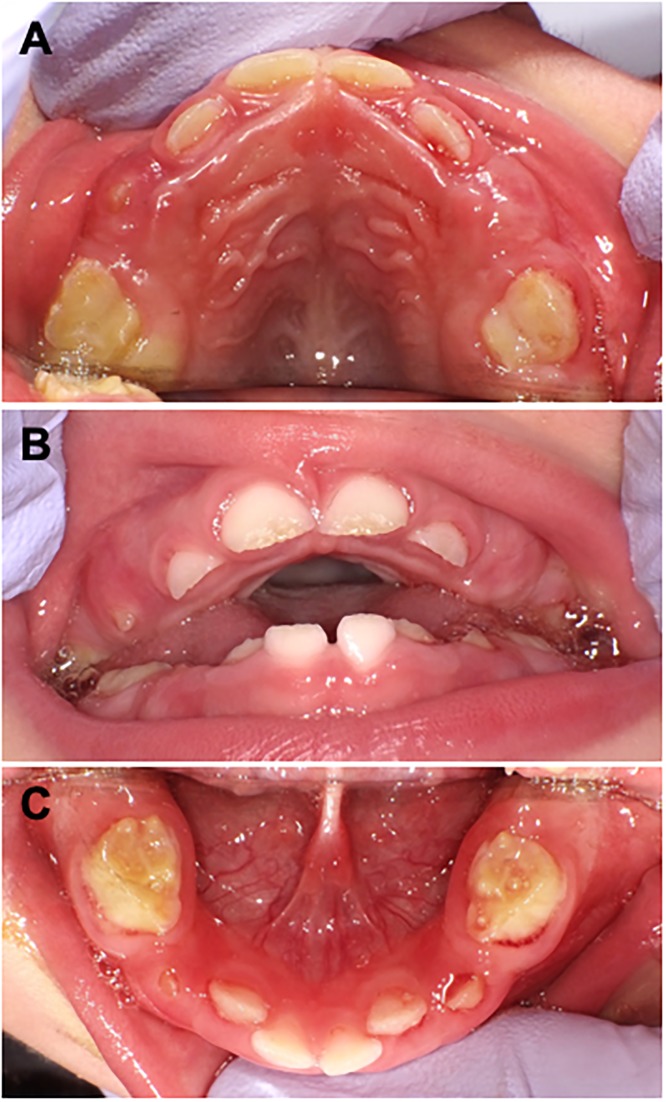
Intraoral photographs of an 18-month-old boy diagnosed with perinatal severe-type HPP.A. Maxillary occlusal view. B. Frontal view. C. Mandibular occlusal view. Typical findings of occlusal problems such as high-arched palate (A), open bite (B), crowding (C), and hypomineralisation of teeth (A–C) were present.